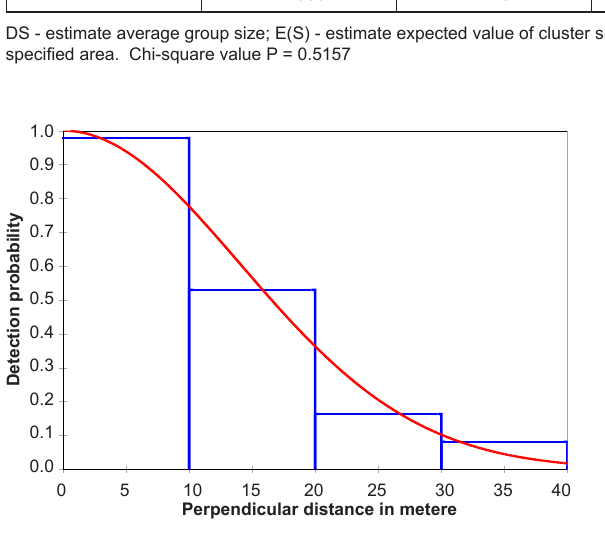
Figure 1. Results of model fitted in the DISTANCE to estimate detection probability and effective strip width of Grey Junglefowl sightings in dry and mixed deciduous habitats of Melghat Tiger Reserve.